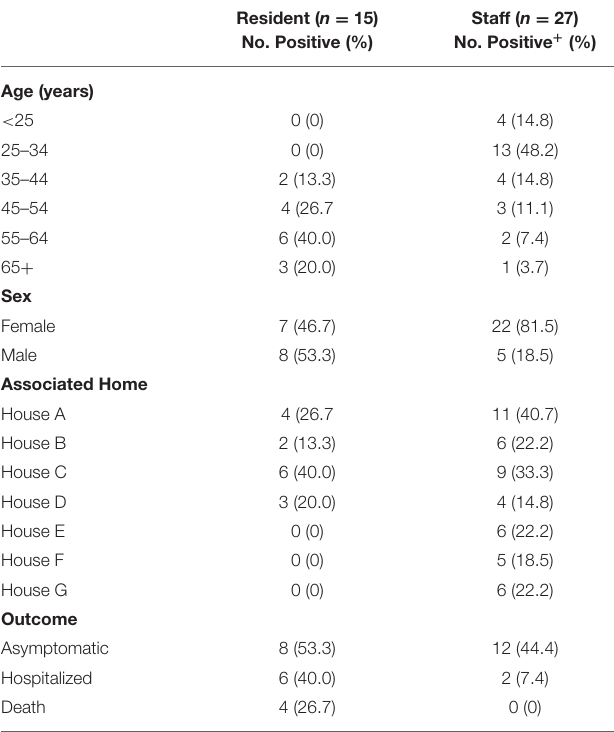
TABLE 1 | Demographic characteristics of COVID-19 positive staff and residents linked to a developmentally disabled adult group home